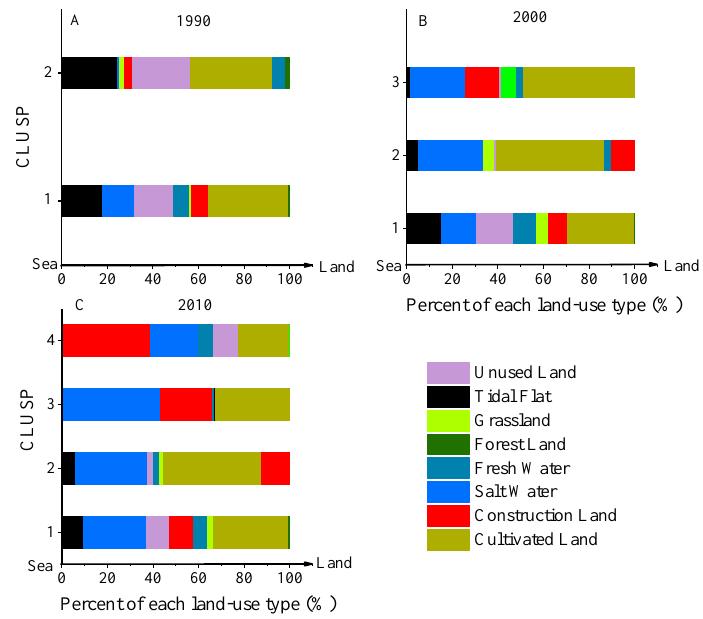
Figure 8. Land use pattern for 1990 ( A ), 2000 ( B ), and 2010 ( C ) along the sea–land Figure 8 . Land use pattern for 1990 ( A ), 2000 ( B ), and 2010 ( C ) along the sea – land direction.